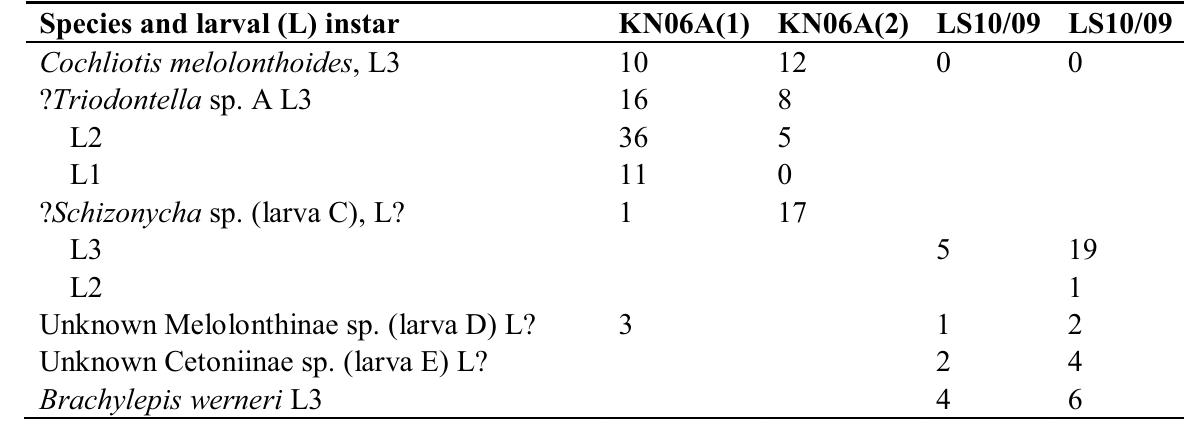
Table 3. The instars and numbers of larvae of white grubs found in four Jepson [7] transects, October